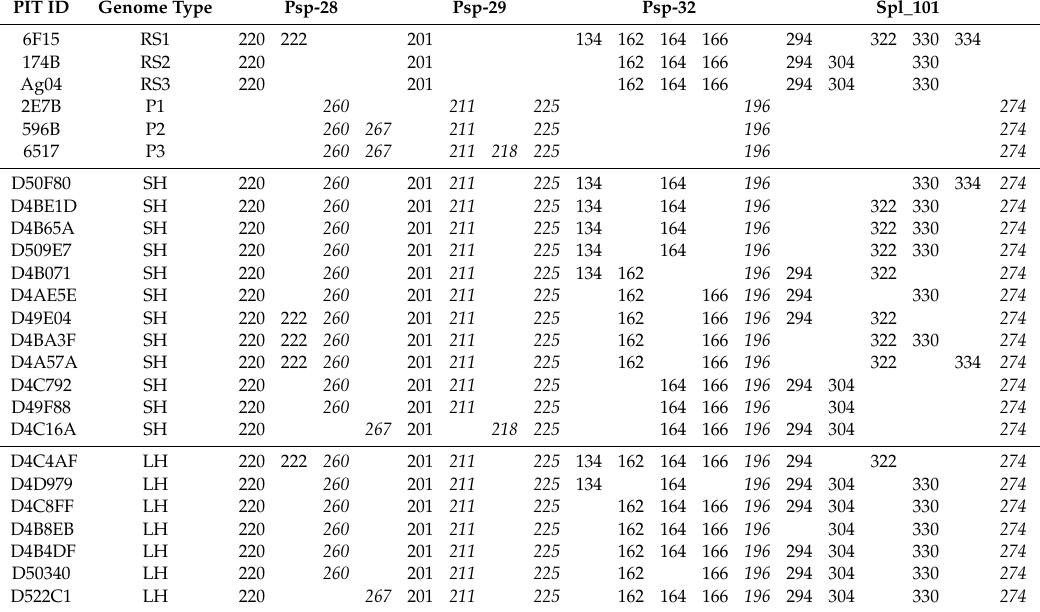
Table 4. Examples of microsatellite genotypes of SH and LH individuals. (RS: Russian sturgeon; P: paddlefish; SH: hybrid with small genome; LH: hybrid with large genome). Psp-28 was disomic, and Psp-29 was tetrasomic on the paddlefish; Psp-28, Psp-32, and Spl-101 were tetrasomic on Russian sturgeon (paternal alleles are in italics). PIT IDs are the individual numbers of internal tags for individual identification.